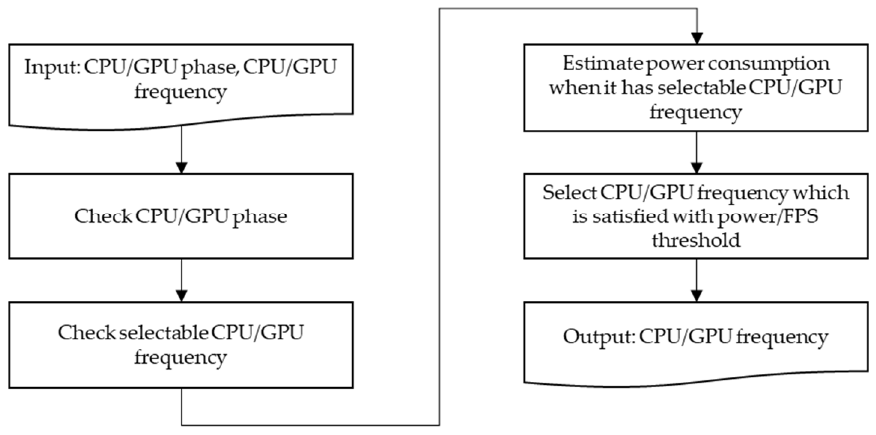
Figure 8. The process of selection of next frequency.